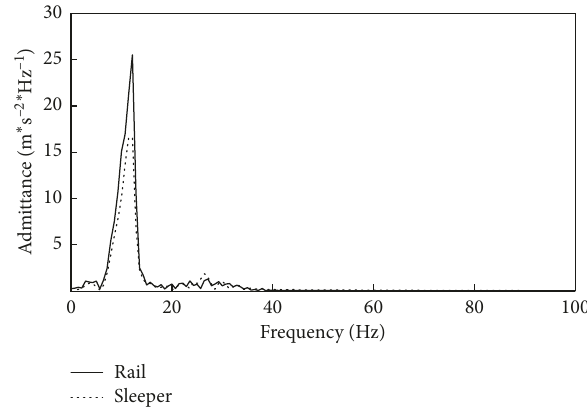
Figure 5: Rail and sleeper vibration acceleration amplitude in frequency